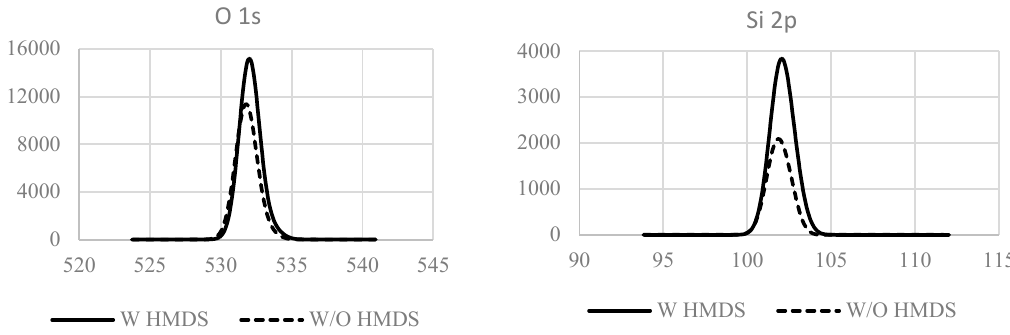
Figure 1. Improvement of the quantum dot light emitting diodes (QD-LED) characteristics by adding a simple step to the conventional fabrication process: ( a ) a schematic for the surface reaction of the quantum dot (QDs) with hexamethyldisilazane (HMDS) and the formation of SiO bond as a consequence, ( b ) high resolution-transmission electron microscopy (HR-TEM) results for both without (W/O) and with (W) an HMDS treatment process. No clear evidence for the formation of the SiO bonds both in W/O HMDS (left) and in W HMDS (right) samples. ( c ) colored energy dispersive X-ray spectroscopy (EDX) results for both without (W/O) and with (W) the HMDS treatment process. Note the clear shape of Si elements only in W HMDS (right) samples. ( d ) X-ray photoelectron spectroscopy (XPS) results of O 1s and Si 2p obtained from the samples without (W/O) and with (W) an HMDS treatment process.